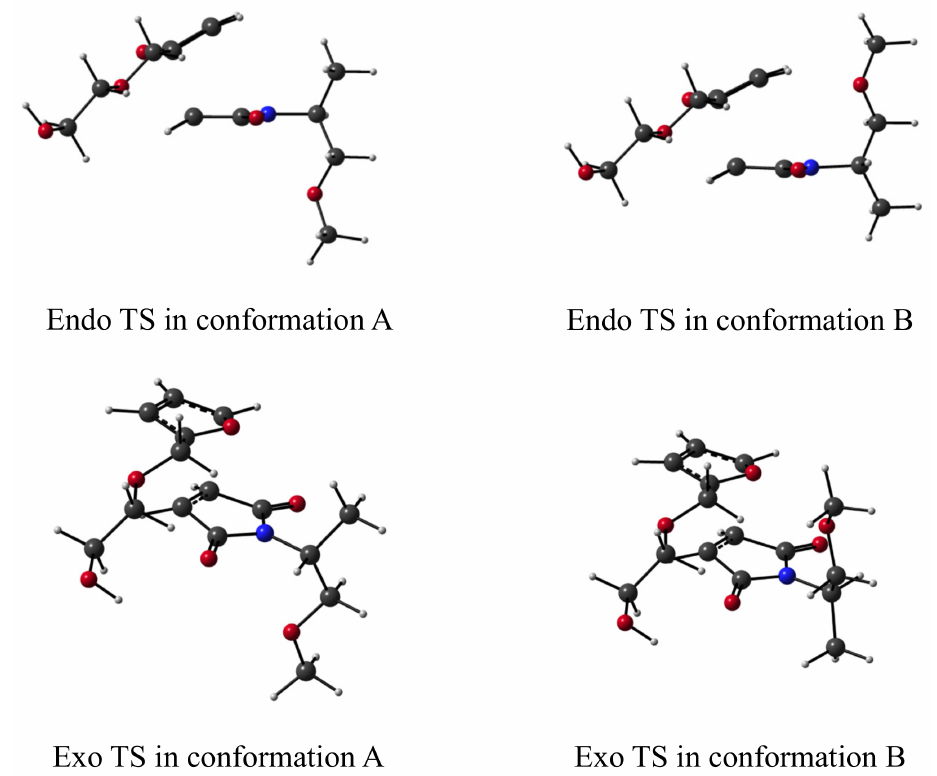
Figure 6. Transition state structures in conformation A and B for the endo and exo cycloaddition reaction. Table 4. The hydrogen bond (HB) length measured in the stationary points of the M[C=O] + F[-OH] reaction. Values are given in Å. RC: reactant complex; TS: transition state; P: product. System RC